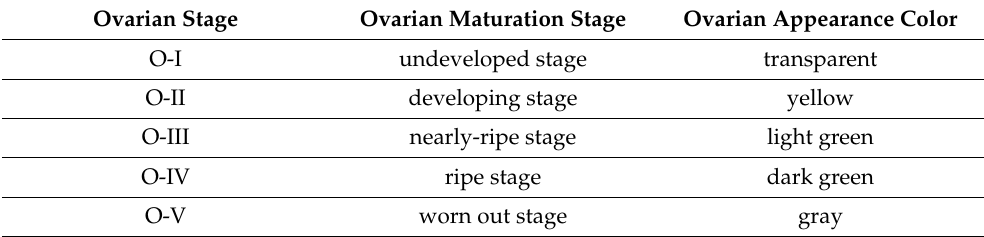
Table 1. Different ovarian stages of M. nipponense . Ovarian Stage Ovarian Maturation Stage Ovarian Appearance Color O-I undeveloped stage transparent O-II developing stage yellow O-III nearly-ripe stage light green O-IV ripe stage dark green O-V worn out stage